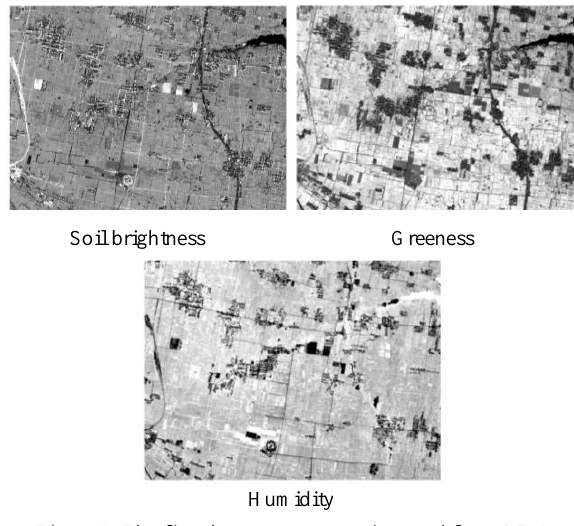
Figure 5. The first three components inversed from GF-1 Tasseled Cap transformation